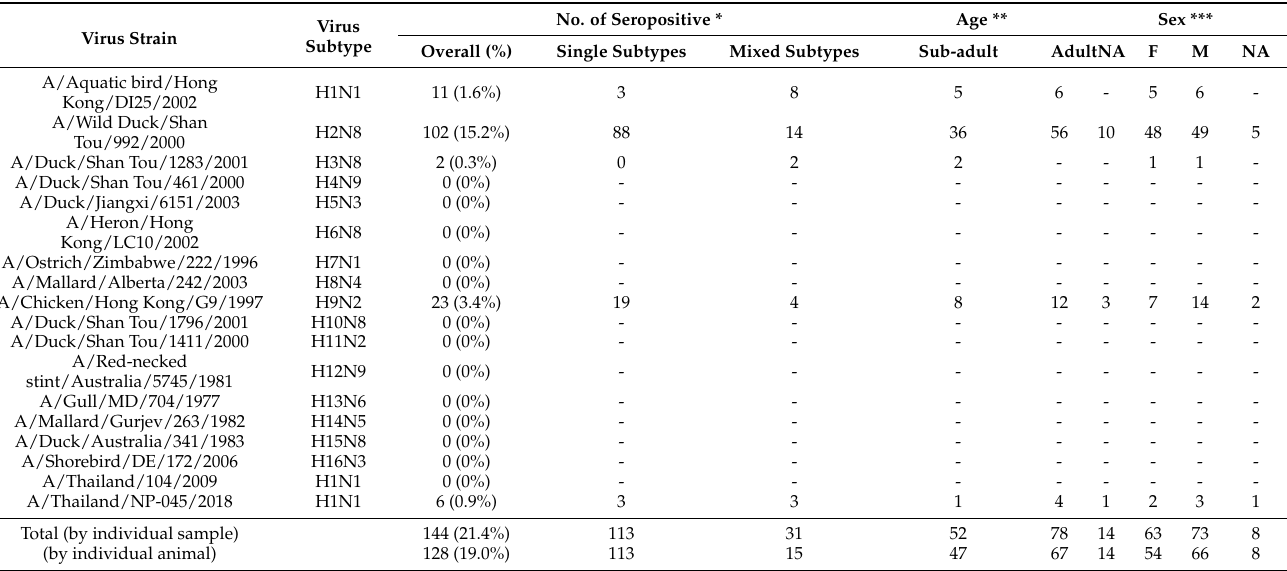
Table 2. Seropositivity against influenza A virus subtypes among free-ranging cynomolgus macaques, Thailand, March–November